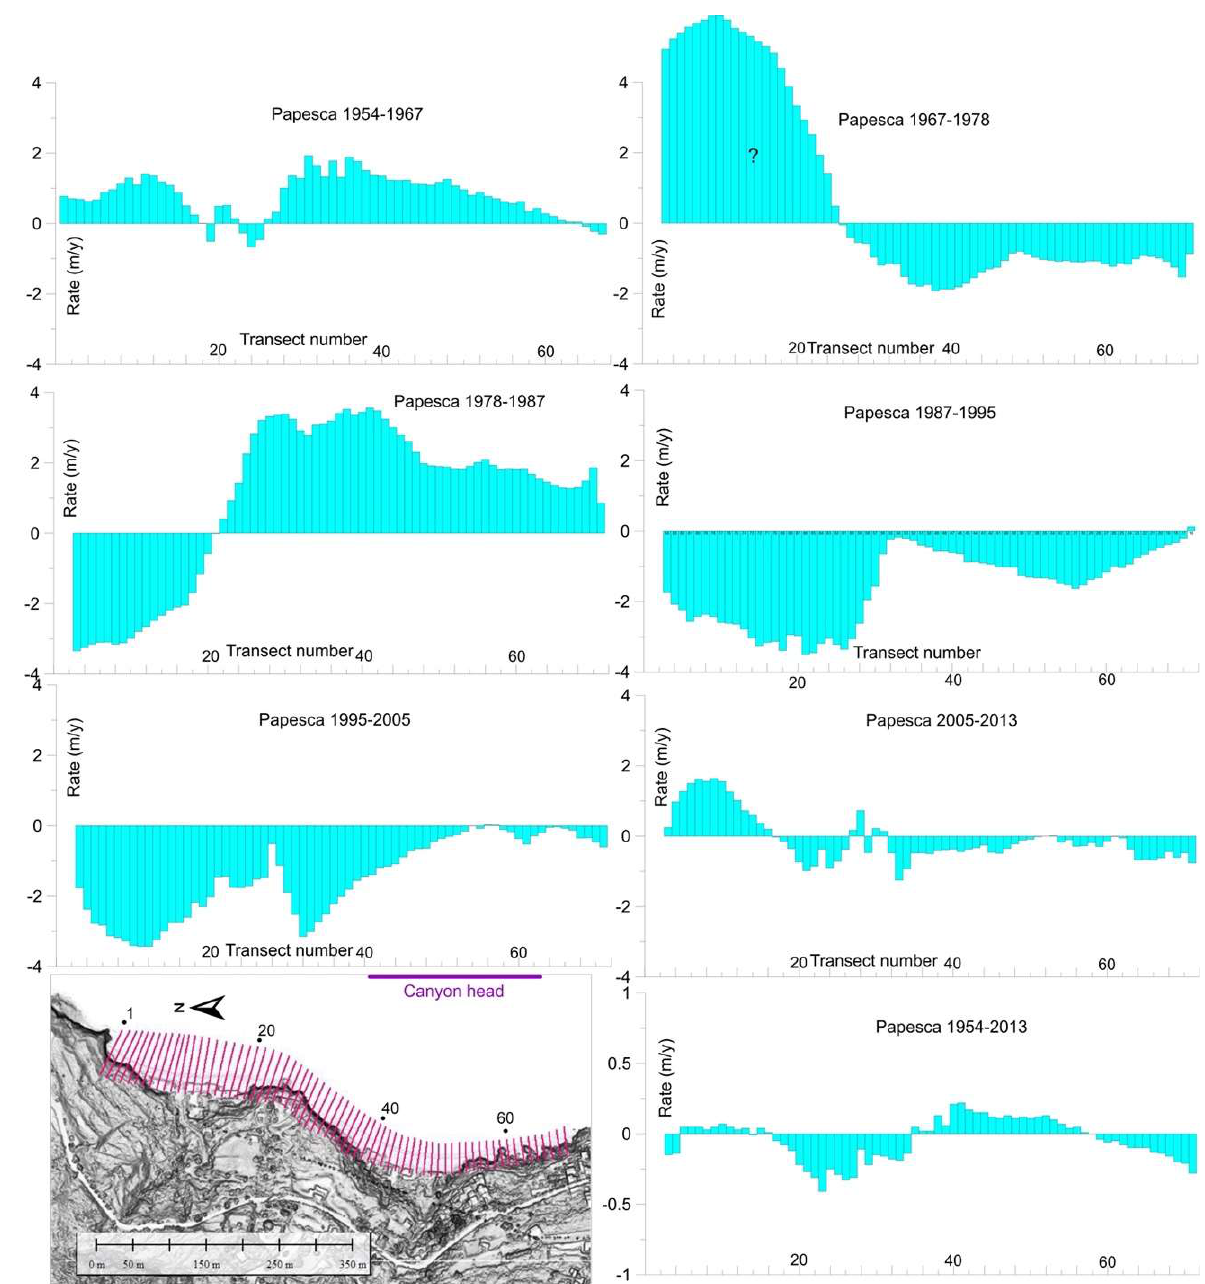
Figure A4. Rate of shoreline displacement for Papesca beach, estimated by means of DSAS along transects spaced 10 m for the different time intervals and for the overall time span of the analysis.